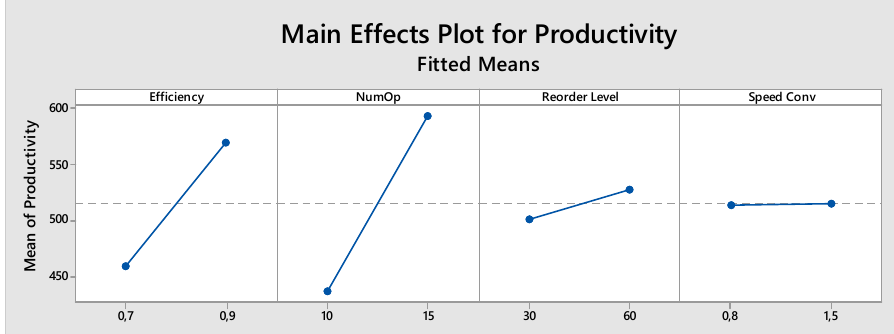
Figure 11. Main Effects Plot for Productivity.